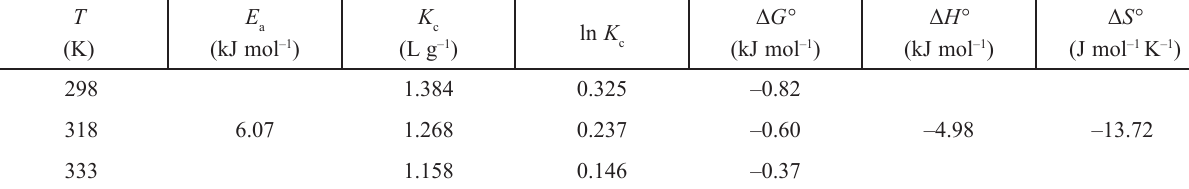
Table 3 – Thermodynamic parameters obtained from kinetic adsorption of CA onto CLDH